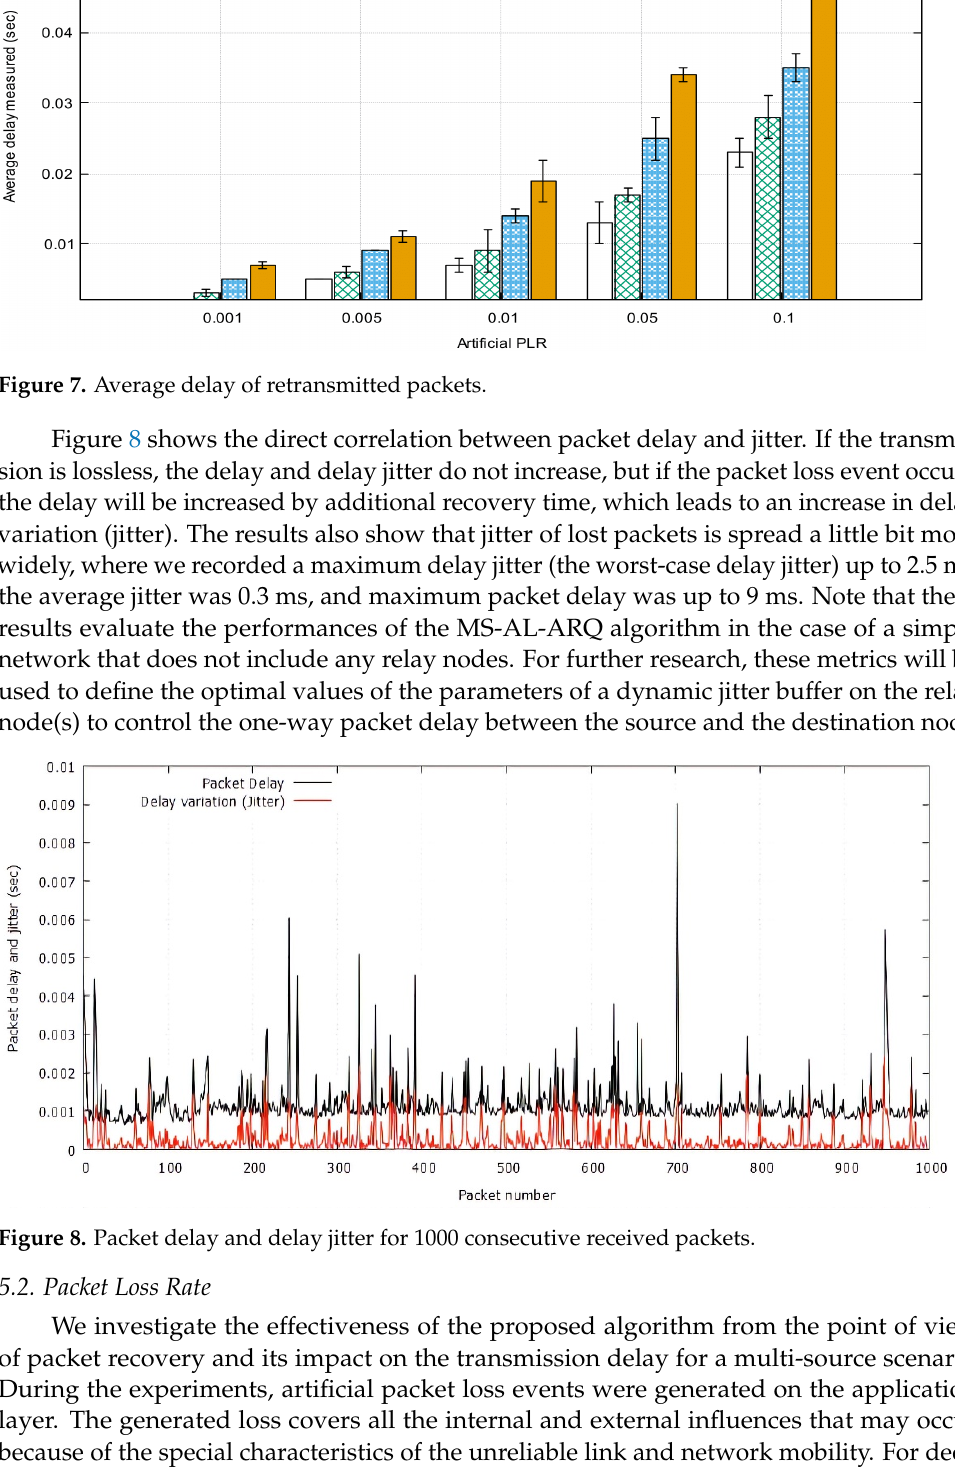
Figure 6. MS-AL-ARQ packet delay (average one-way packet delay) for different packet loss rate (PLR) and burst length (BL) values.